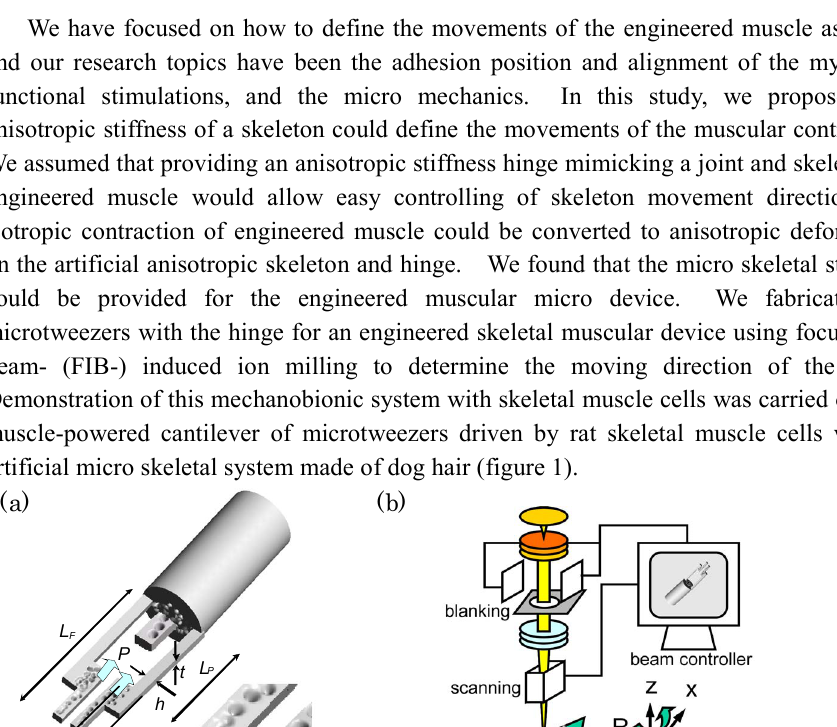
Fig. 1 Bio hybrid muscle-powered microtweezers with rat primary myocytes and dog body hair. Myoblasts fused to form a multinuclear myotube on the micro fabricated hair skeleton.